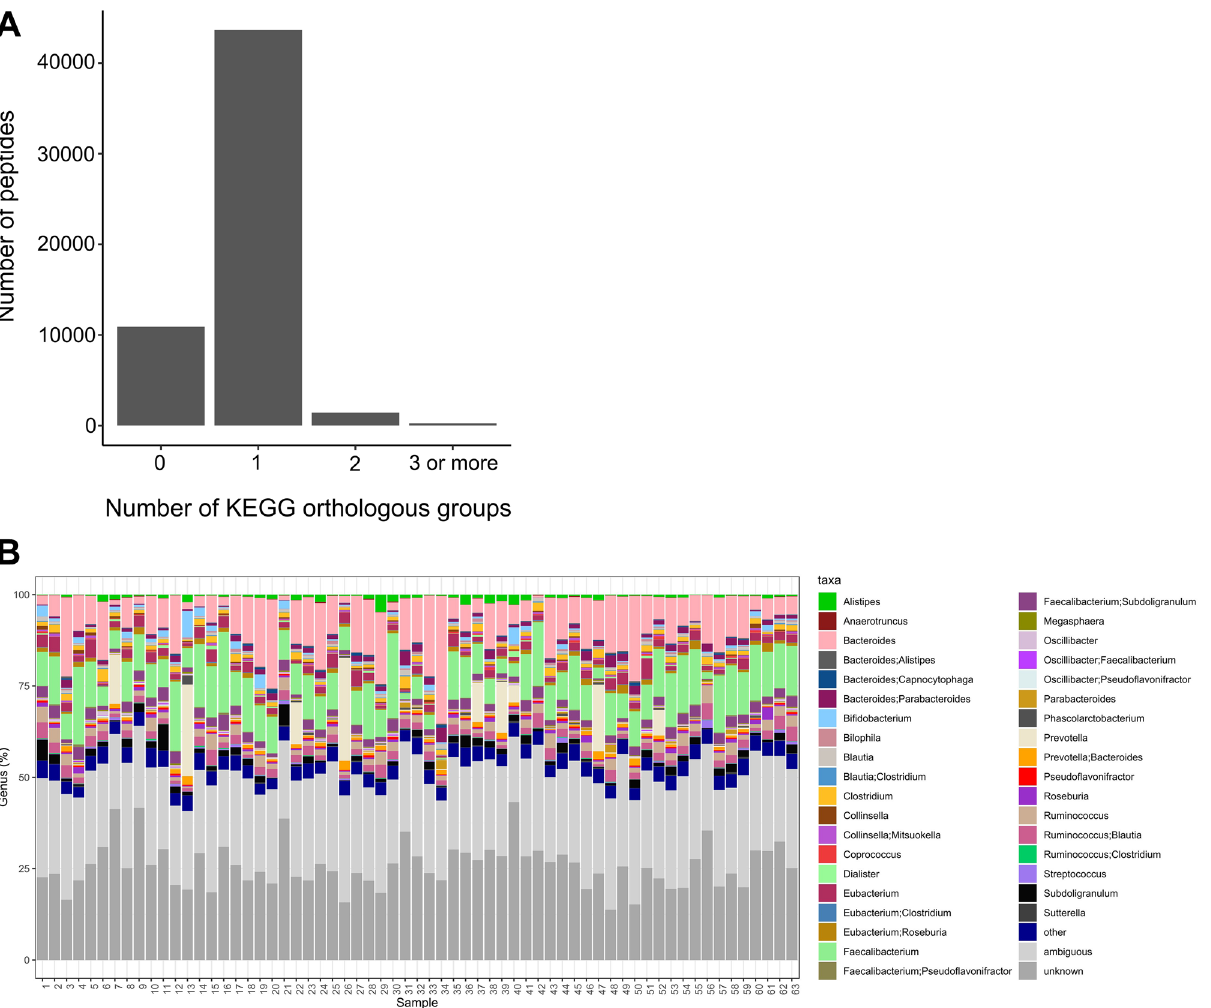
unanimously annotated to one bacterial genus, while appr. 40–60% of peptides was shared by two or more genera. Peptides remaining without taxonomic annotation constituted 13.8–43.2% of peptides. (For a particular genus, see color